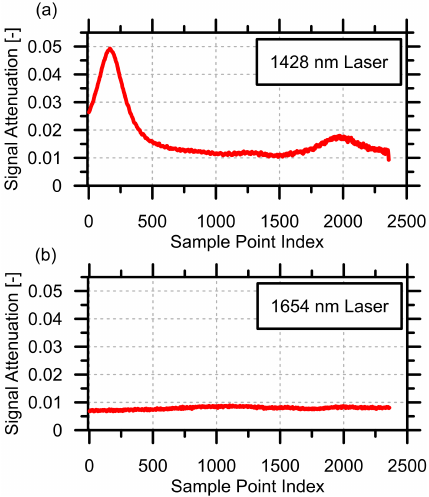
Figure 4. Sample 5ms duration measurement of (a) 1428nm (H 2 O + BC) and (b) 1654nm (BC) laser signals through a Bakken flare plume. Time-resolved signals can be mapped to isolate spectral H 2 O absorption peaks from black